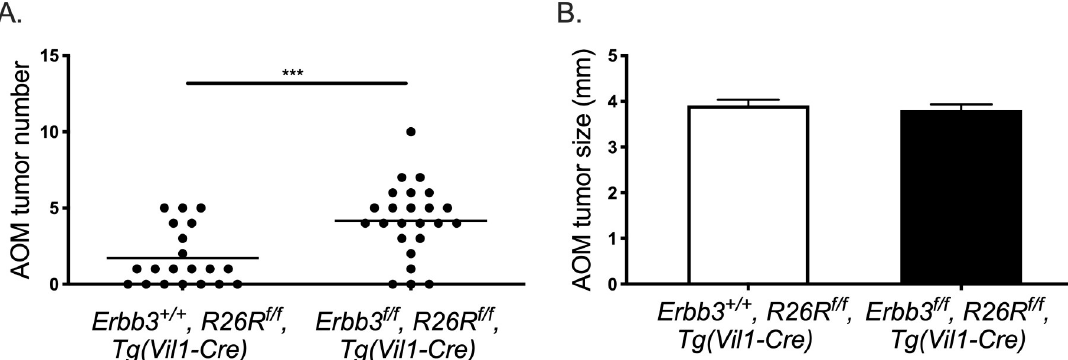
tumor size of colon polyps with normal ERBB3 and black bars represent the mean tumor size of ERBB3-deficient colon polyps induced by AOM. � p-value < 0.05, �� p-value < 0.01, ��� p-value < 0.001, ���� p-value <